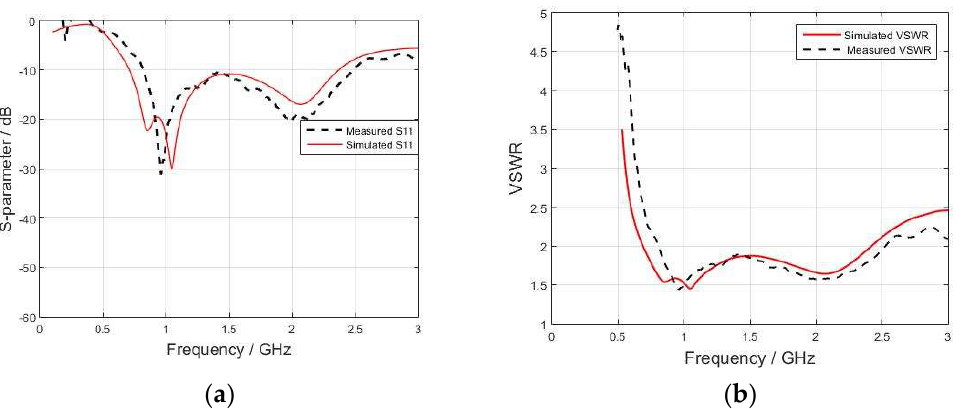
Figure 12. ( a ) Simulated and measured return losses vs. frequency, and ( b ) simulated and measured VSWR vs. frequency.